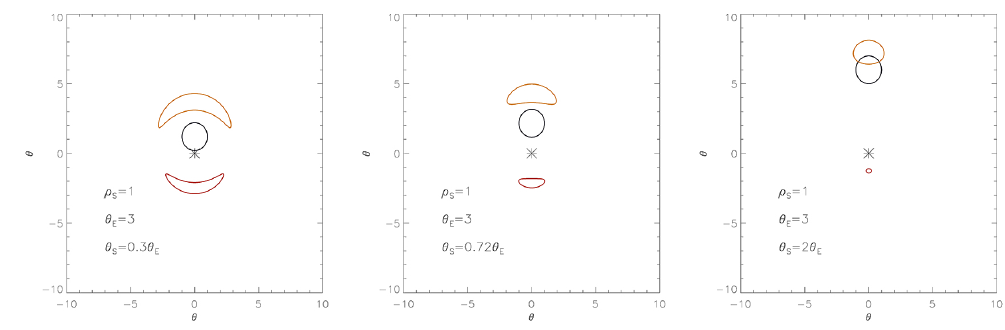
Figure 3. As in Figure 2, but with a conformal transformation of the source boundary, considered extended and with radius ρ S , by a point-like lens. Each point of the source disk behaves as a point-like source. The black circle represents the source disk, while the red and yellow arcs are the deformed primary and secondary